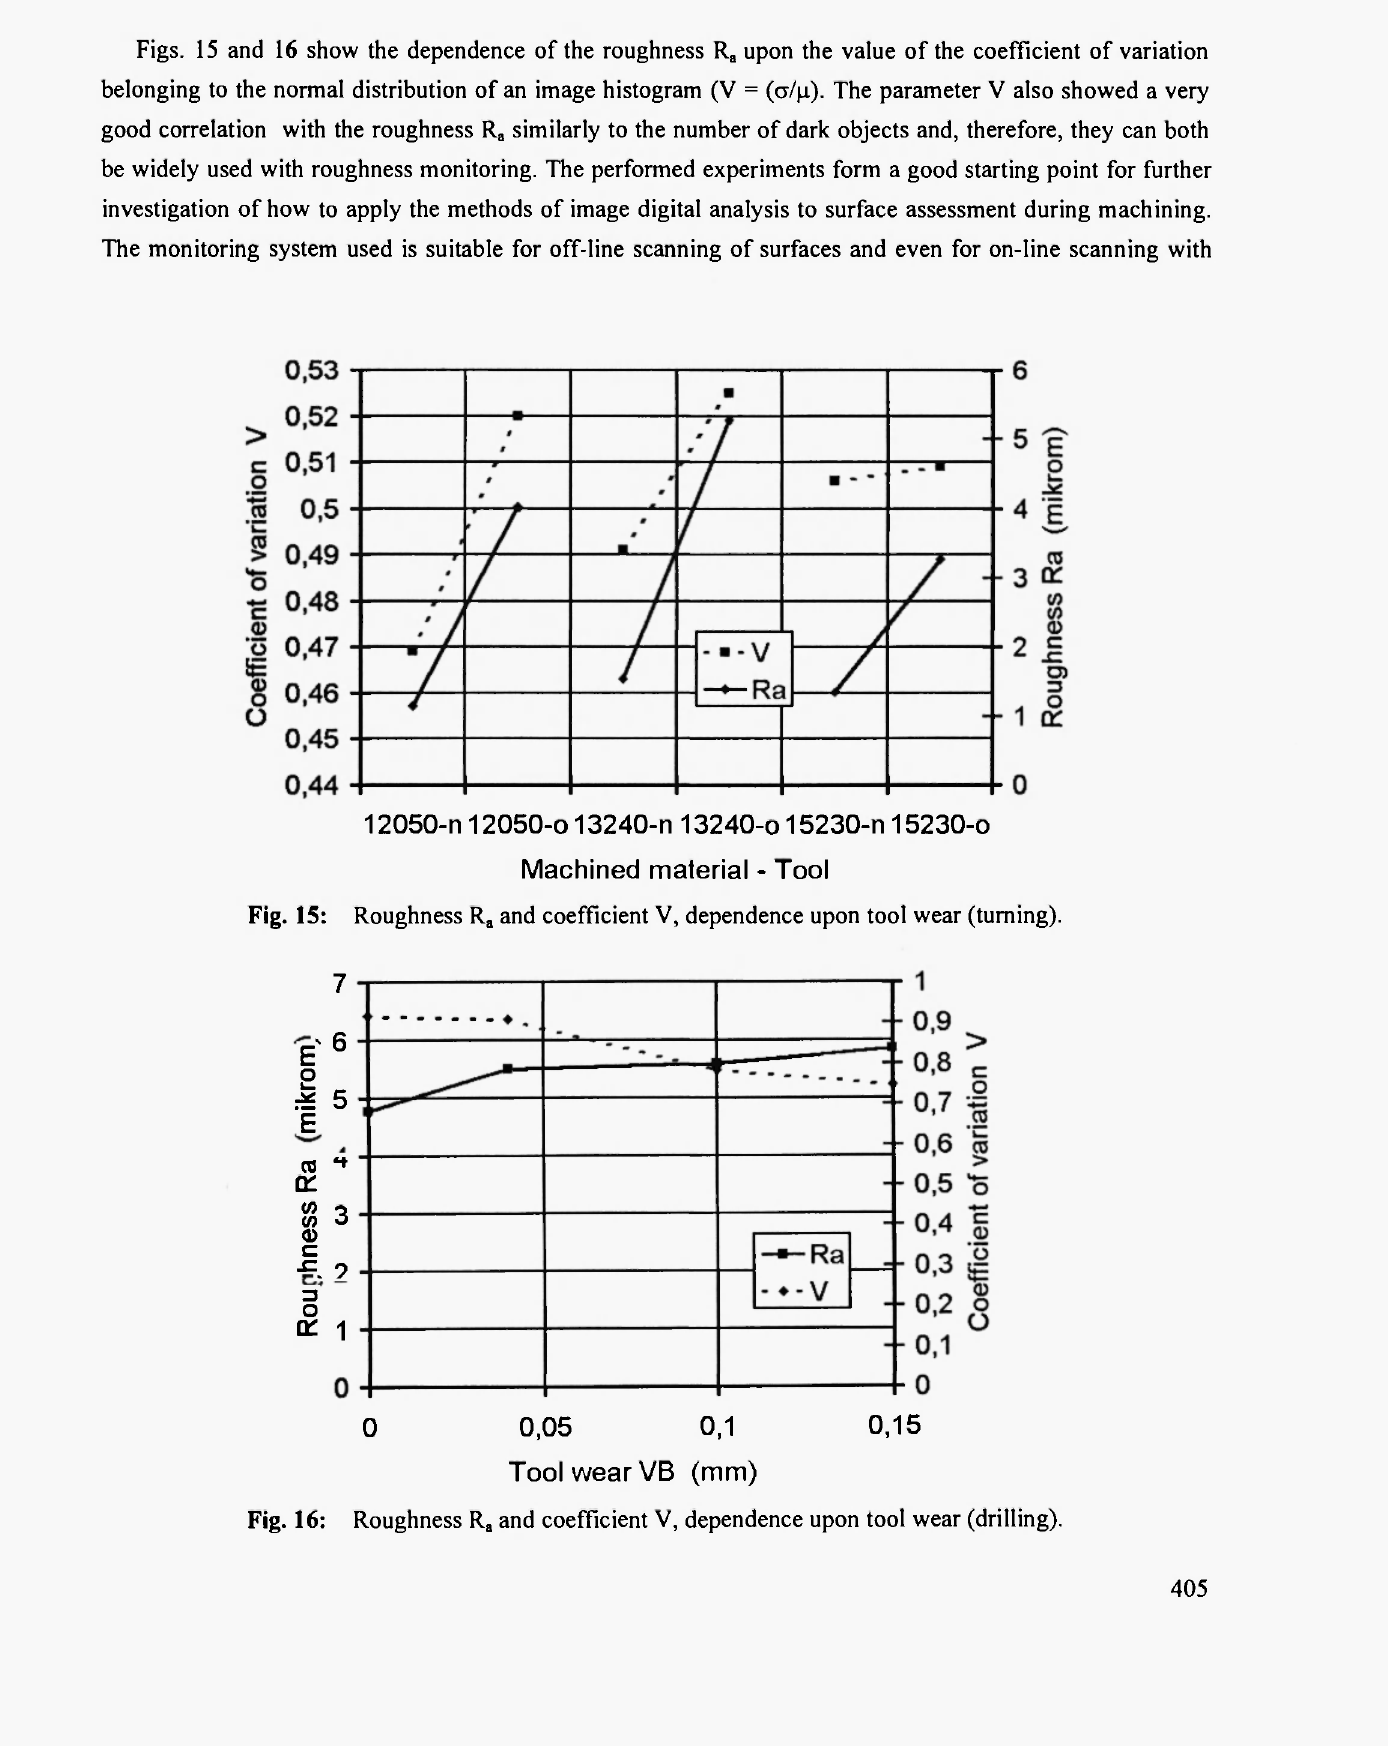
Machined material - Tool Fig. 15: Roughness R a and coefficient V, dependence upon tool wear (turning).